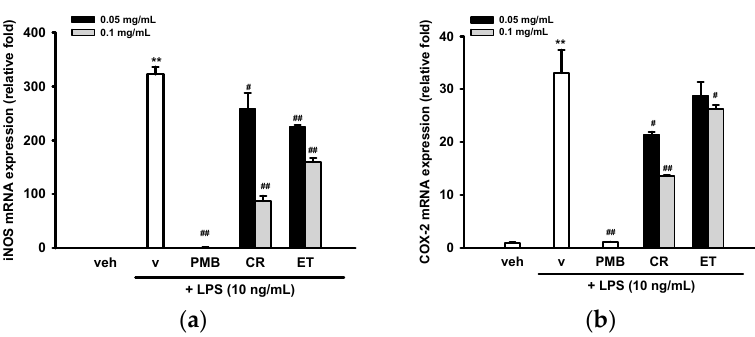
Figure 3. Effects of ethanol extracts of C. rutidosperma and E. thymifolia on the mRNA expression of iNOS and COX-2 in LPS-treated BV2 cells. BV2 cells were cultured with indicated reagent in six-well plates for 4 h followed by RNA extraction and RT-Q-PCR for measuring mRNA levels of iNOS ( a ) and COX-2 ( b ), as described in Materials and Methods. Data are represented as the mean ± SD ( n = 3). Statistical differences are presented ** p < 0.01 compared with the vehicle control (without LPS) and # p < 0.05; ## p < 0.01 compared with the LPS-treated vehicle.